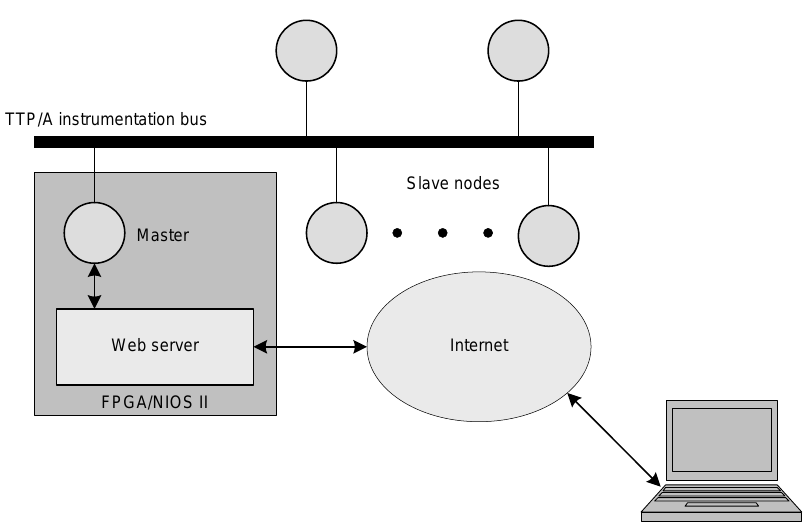
Figure 1. The implemented system general